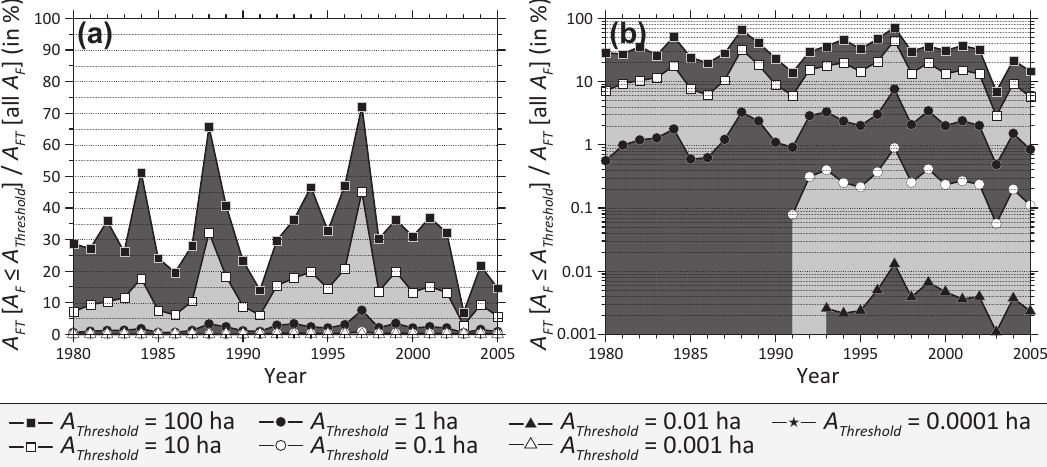
Fig. 6. Percentage of Continental Portugal yearly burnt area ( A FT ) using just those burnt area fire records A F ≤ A Threshold = 0.0001, 0.001, 0.01, 0.1, 1, 10 and 100ha, each given as a percentage of the corresponding total values in each year, 1980–2005: A FT [ A F ≤ A Threshold ]/ A FT [all A F ], is given for (a) linear axis and (b) log